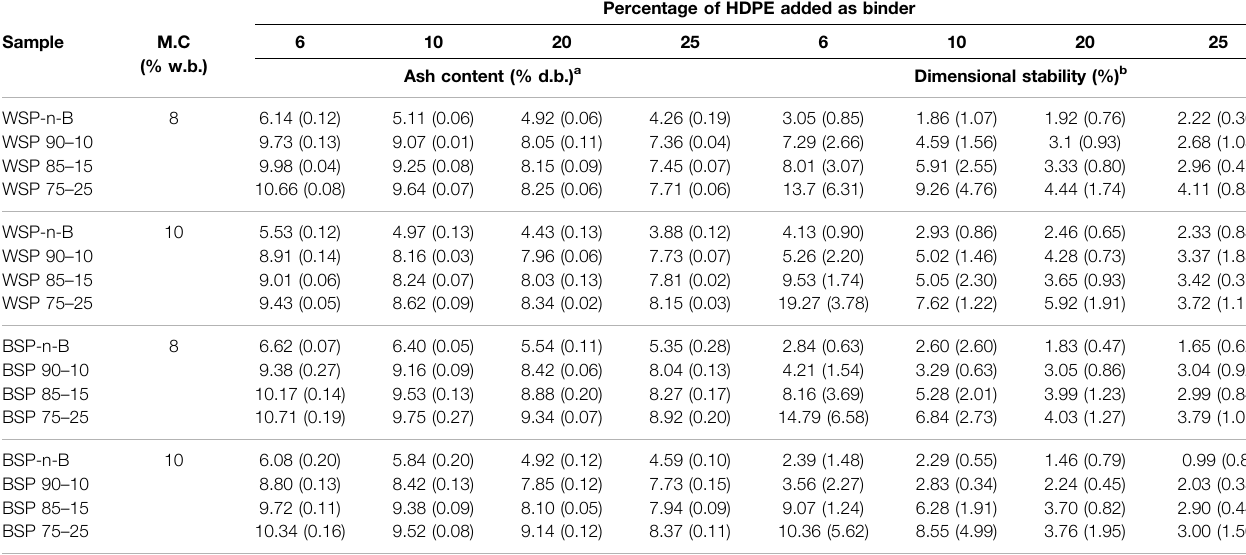
Percentage of HDPE added as binder